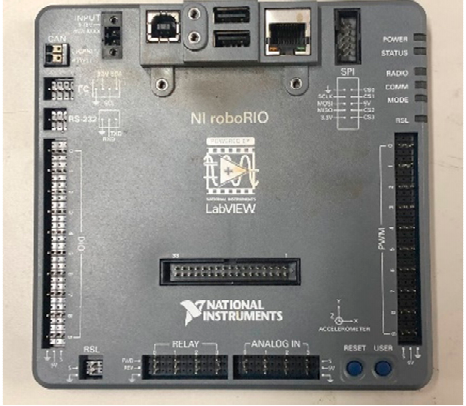
Figure 3. The physical appearance of NI-roboRIO.